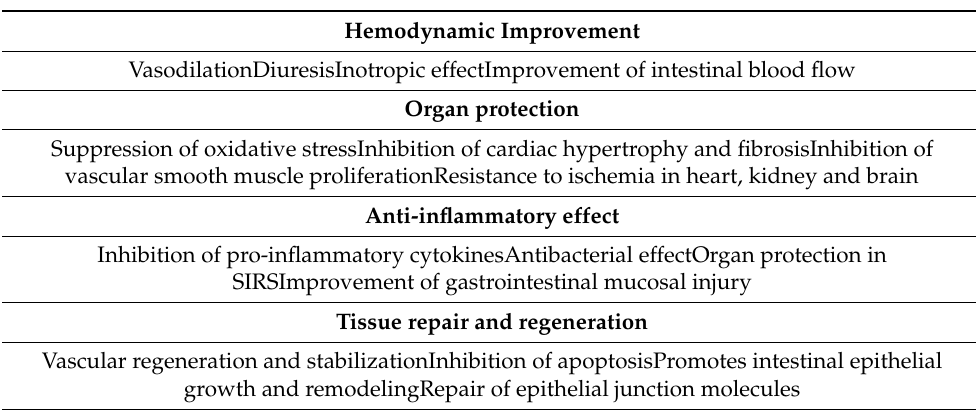
Table 1. Diverse physiological effects of adrenomedullin.